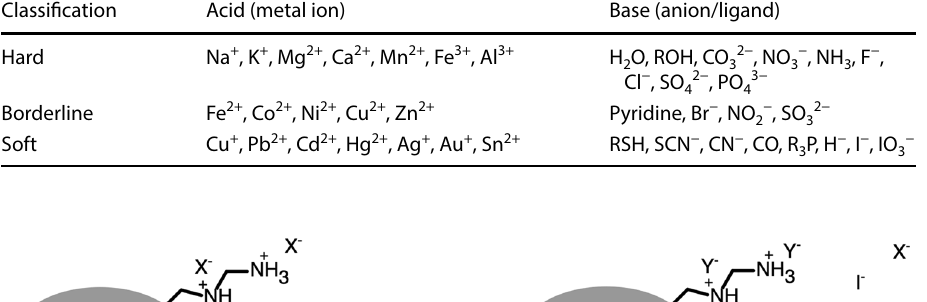
Fig. 2 Comparison of the uptake mechanisms for iodide removal for an anion- exchange resin (top) and a metallated resin operat- ing via complex-formation and ligand-exchange, using bispicolylamine group as an example. M = multi-valent metal ion. X = low-affinity ion / labile